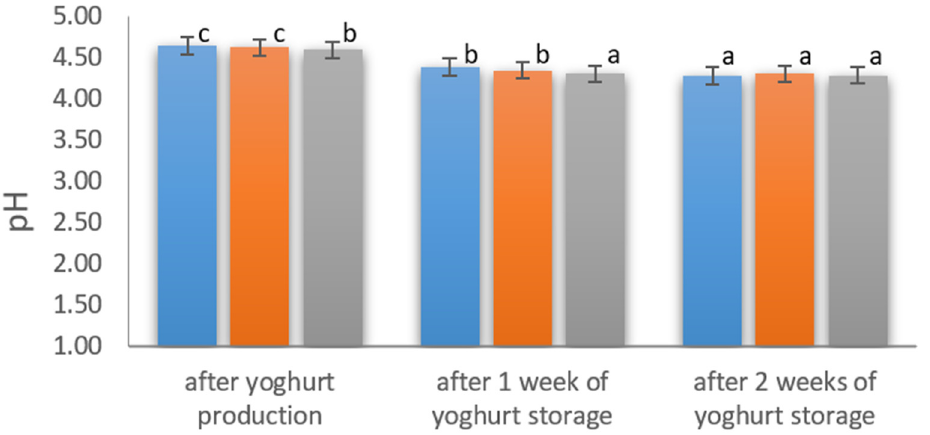
Figure 4. Changes in acidity [pH] during the storage of yoghurts fortified with the addition of 2% of skim milk powder [blue], casein hydrolysate [orange], casein–iron chelate [grey] (mean values with different letters ( a,b,c , etc.) within a single-color component are statistically different ( p < 0.05)).